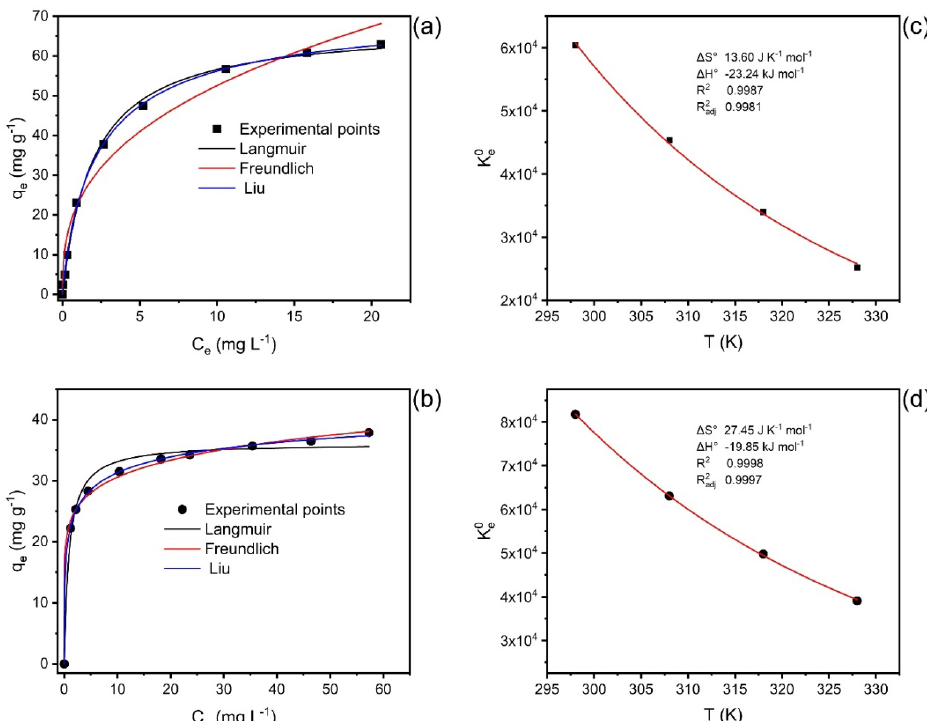
Figure 6. Isotherms at 298 K ( a , b ) and nonlinear plot of Van’t Hoff ( c , d ) for the uptake of Nd(III) onto LEB-18 ( a , c ) and LEB-52 ( b , d ) S. platensis biosorbent. Table 5. Nd(III) adsorption thermodynamic parameters onto LEB-18 and LEB-52 biosorbents. Temperature (K)